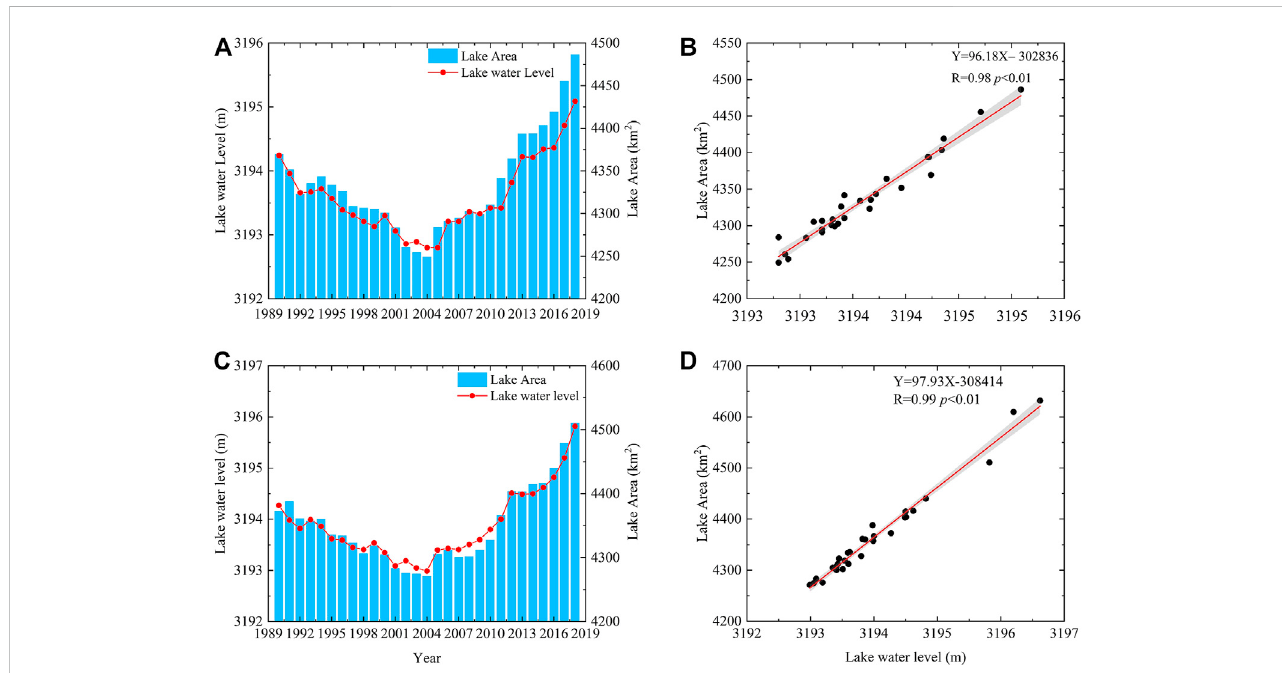
FIGURE 4 VariationofmonthlylakewaterlevelandsurfaceareaforApril (A) andSeptember (C) ,andlinearcorrelationsbetweenlakewaterlevelandsurfaceareafor April (B) and September (D) .